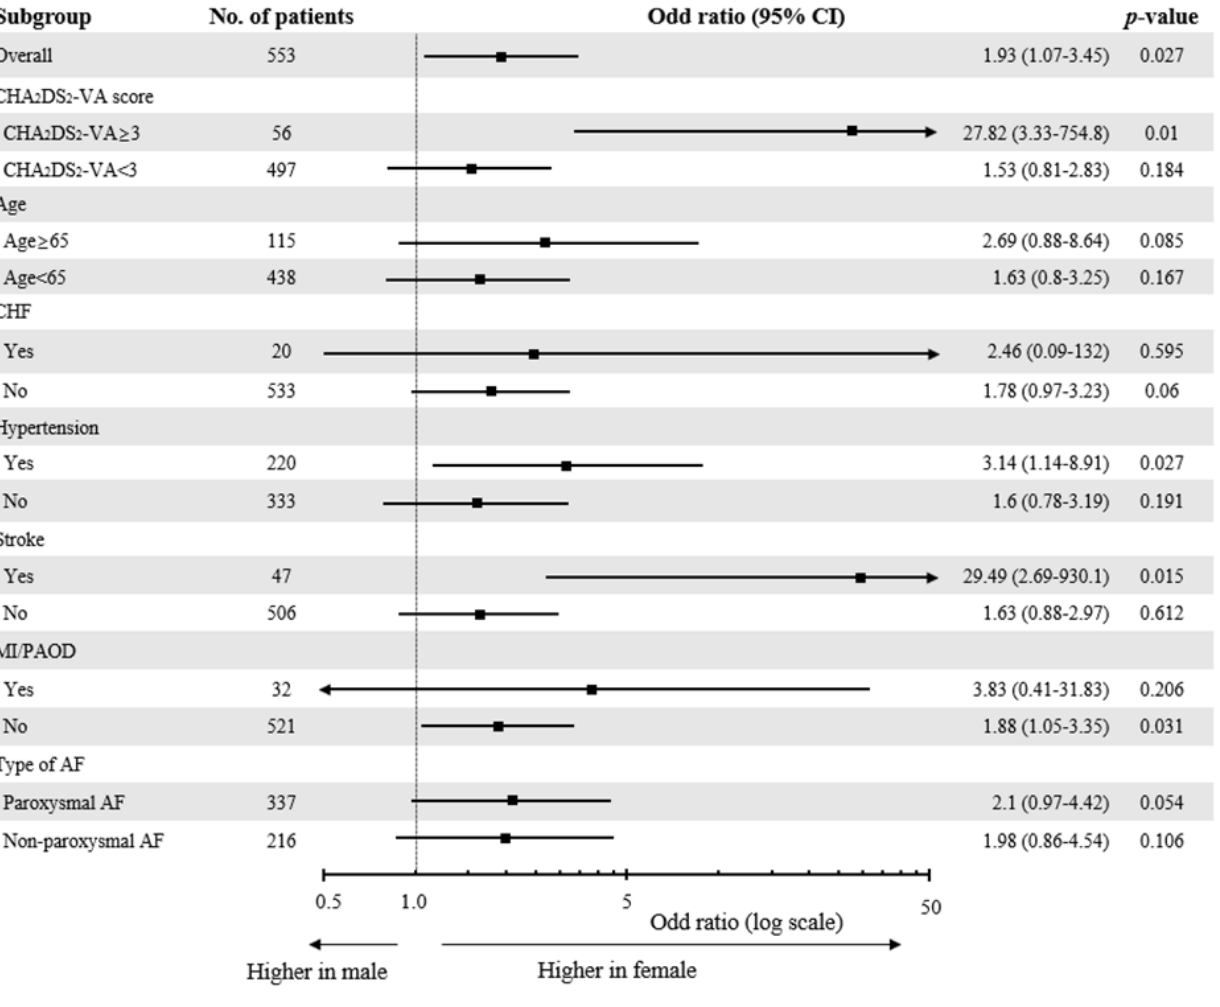
Figure 3. Multivariate logistic regression analysis performed to evaluate the association between female sex and extensive LVA burden (LVA proportion ≥ 30% (stage IV)). Age, number of non-sex criteria risk factors (heart failure, hypertension, diabetes mellitus, myocardial infarction, or peripheral artery disease), type of AF, AF duration, LA diameter ≥ 4.5 cm, LV ejection fraction, and estimated glomerular filtration rates (eGFR) were entered into the model. CHF, congestive heart failure; MI, myocardial infarction; PAOD, peripheral artery occlusive disease; AF, atrial fibrillation. Table 2. Univariate and multivariate associations of clinical variables with LA low voltage areas using linear regression model.